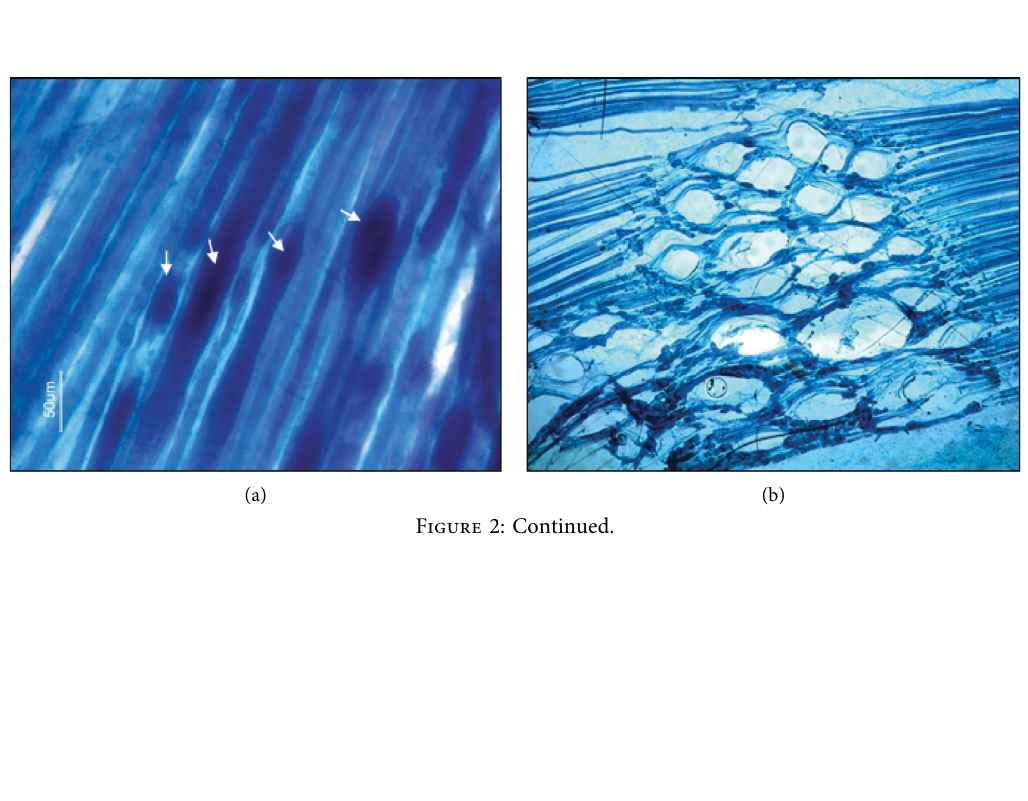
Figure 1: Ex vivo dry needling with solid needle in normal healthy LAL muscle. (a) Three punctures were performed in the innervation area of the muscle. Note that few muscle fibers are injured, and the needle sets many of them a side (initial magnification: 100x). (b) Detail of a puncture. The SEM image is an example of a solid needle habitually used for acupuncture and dry needling (diameter of 250 μ m). Ar- rowheads, muscle fiber injury points. Two images are on the same scale (scale bar: 50 μ